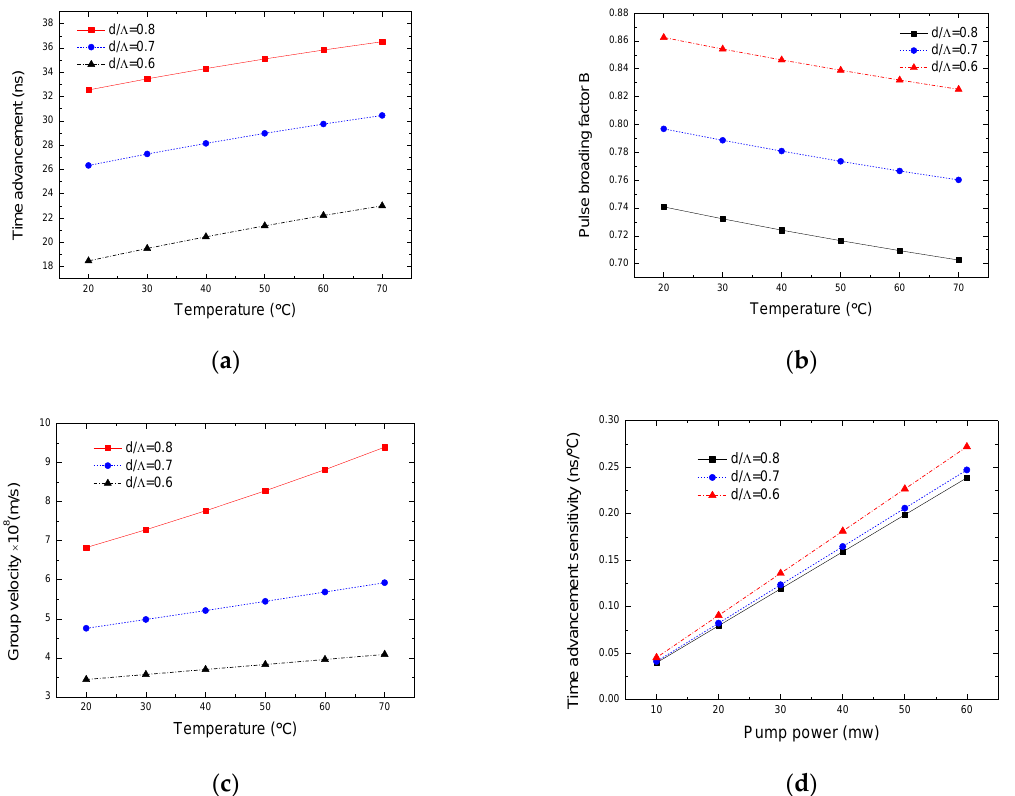
Figure 8. ( a ) Time advancement, ( b ) pulse broadening factor and ( c ) group velocity of signal light varies with temperature. ( d ) Time advancement sensitivity varies with pump power.